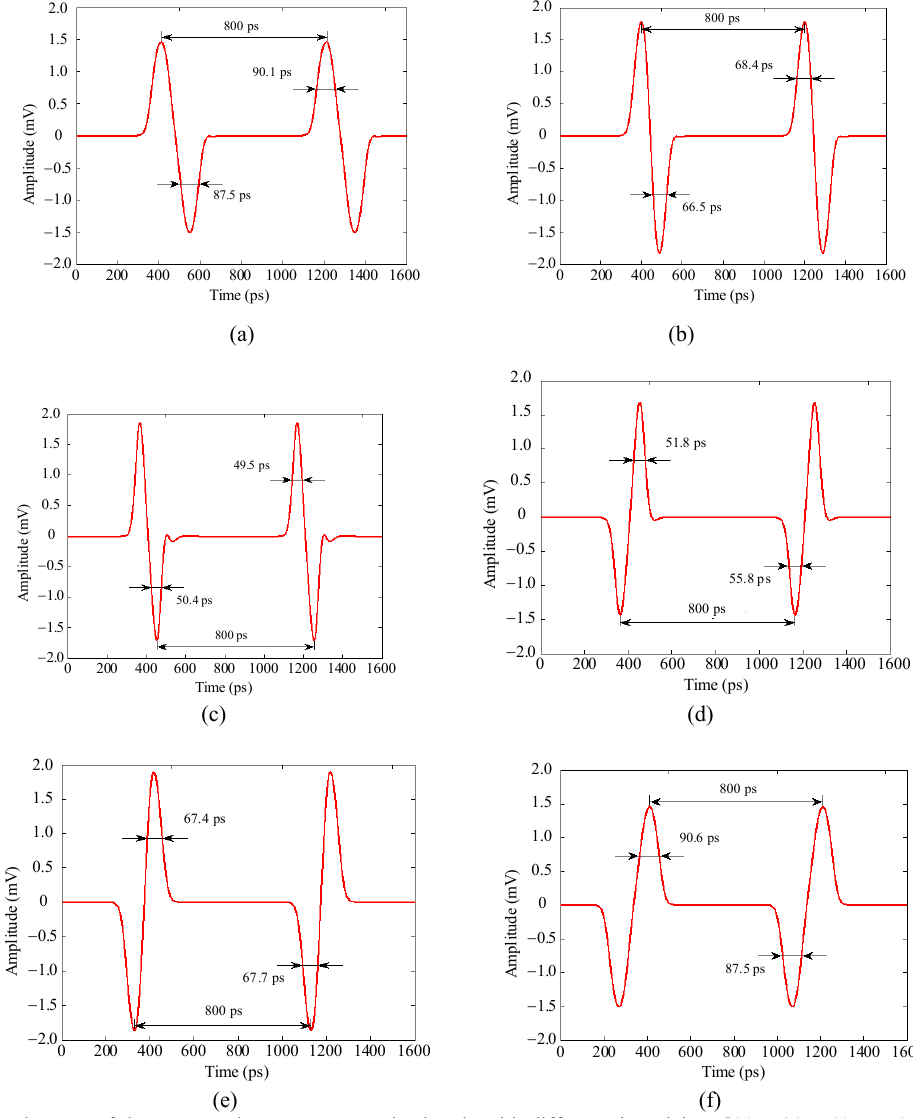
Fig. 3 Temporal traces of the generated UWB monocycle signals with different time delays [(a) ‒ (c): 140 ps, 70 ps, and 10 ps] and advances [(d) ‒ (f): ‒ 10 ps, ‒ 70 ps, and ‒ 140 ps]: (a) ‒ (c) positive UWB monocycle and (d) ‒ (f) negative UWB monocycle. Figure 6 plots the variation in the RF spectrum when the time delay or advance is varying. From Fig. 6(a), we know that the central frequency and 10-dB bandwidth of the generated positive UWB monocycle can be tuned from 3.30 GHz to 5.40 GHz and from 5.34 GHz to 8.86 GHz, respectively; for the negative UWB monocycle, they can be tuned from 3.24 GHz to 5.11 GHz and from 5.23 GHz to 8.30 GHz, respectively. Figure 6(b) shows that, the fractional bandwidth of the generated monocycle signal have very slight fluctuation between Fig. 4 Pulsewidth depending on the time delay.